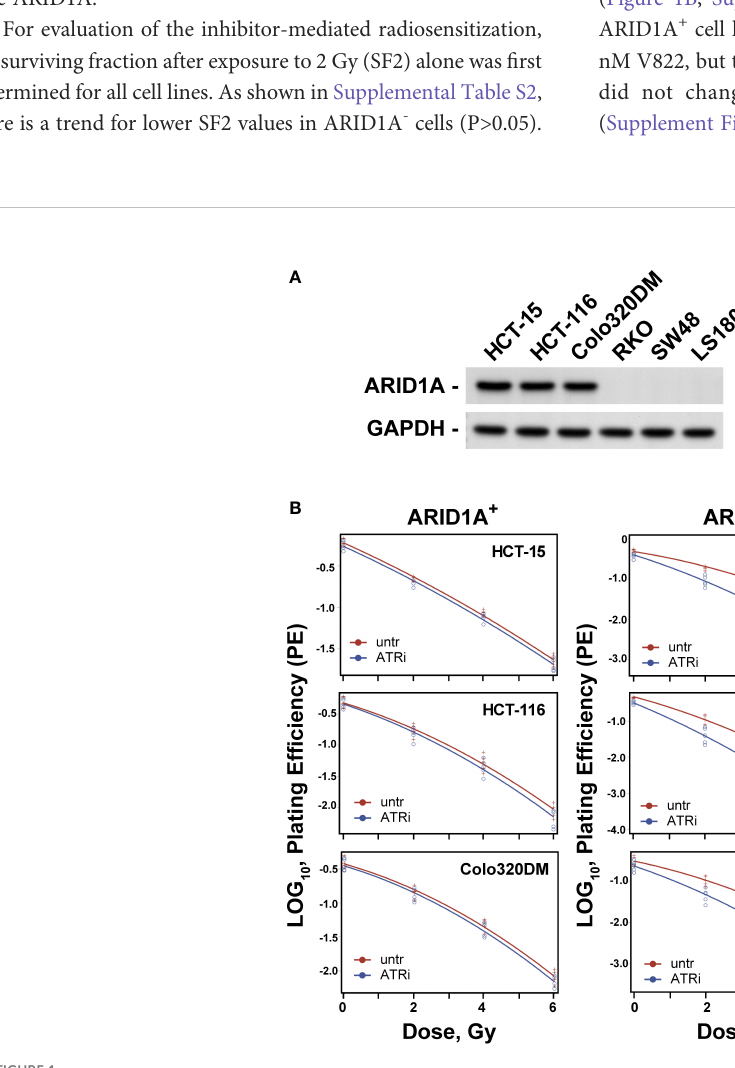
FIGURE 1 Effect of ATRi on radiosensitivity. (A) ARID1A expression in colon cancer lines; (B) Effect of ATRi (VE822) on radiosensitivity. ARID1A+ and ARID1A- cell lines were pre-treated for 1 h with 20 nM VE822 and irradiated with 0 Gy, 2 Gy, 4 Gy and 6 Gy. Plating ef fi ciency of sham treated (untr) and VE822 treated (ATRi) cells were plotted as log10 for ARID1A + and ARID1A - cell lines. Results of 3 independent experiments are shown for CRC cell